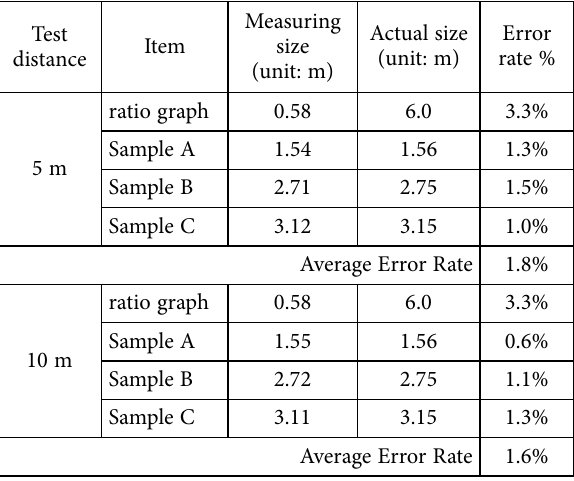
Table 1. Verification error rate analysis